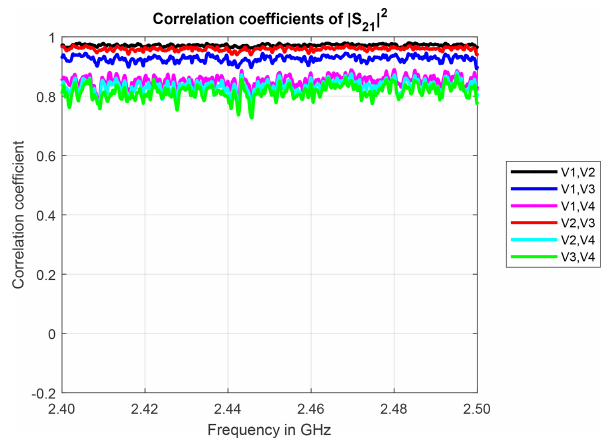
Figure 5. Power correlation coefficients for identically constructed antennas and measurement trial 4. Table 4. Mean values of the power correlation coefficient over fre- quency for different antenna pairs.